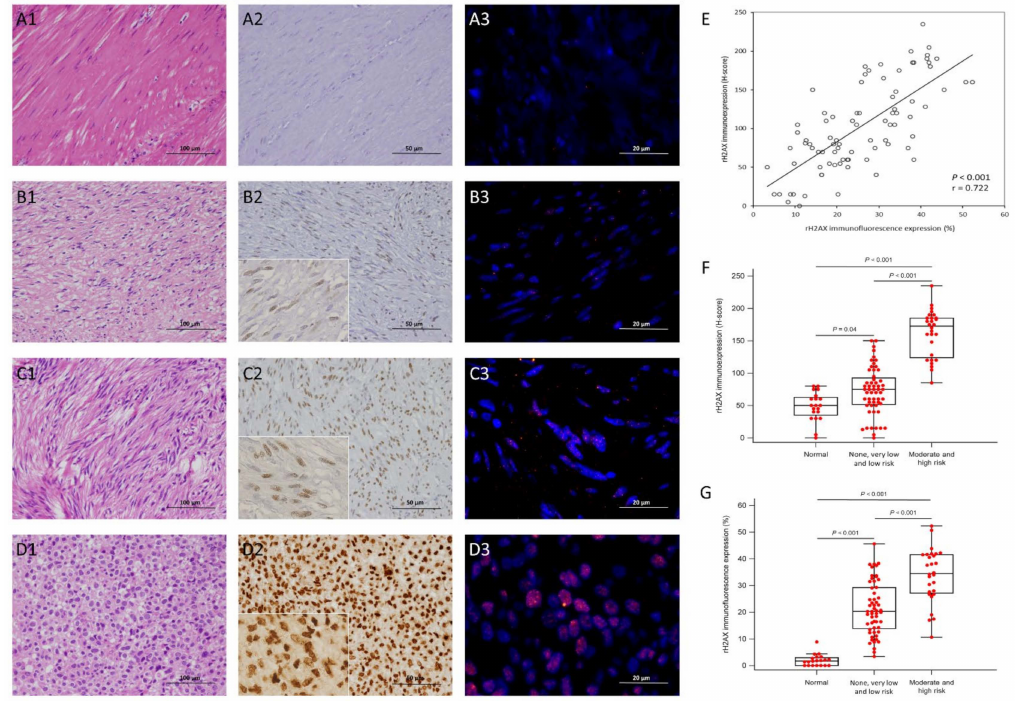
Figure 2. Immunohistochemical and immunofluorescence expressions of rH2AX in gastrointestinal stromal tumors across various risk categories. Representative adjacent normal tissue ( A1 ) and gastrointestinal stromal tumors (GISTs) at low-risk ( B1 ), moderate-risk ( C1 ), and high-risk ( D1 ) levels exhibited no ( A2 ) to weak ( B2 ), moderate ( C2 ), and diffuse strong ( D2 ) immunohistochemical (IHC) nuclear rH2AX reactivity ( × 200), respectively, in a granular pattern, as highlighted in the insets ( B2 – D2 , × 400). In the immunofluorescence analysis of rH2AX, the percentages of positively labeled nuclei, presenting as fine to coarse red speckles, increased gradually from normal ( A3 ) to low-risk ( B3 ), moderate-risk ( C3 ) and high-risk ( D3 ) GISTs. ( E ) The scatter plot reliably demonstrates a strong association between the H-score of rH2AX immunoexpression on the Y -axis and immunofluorescence expression on the X -axis ( p < 0.001, r = 0.722). Compared to the normal tissues, the expression levels of rH2AX determined by IHC (( F ) , p < 0.001) and IF (( G ), p < 0.001) assays were significantly elevated in the 84 GISTs; the major differences occurred in normal tissues versus none/very low-/low-risk cases (IHC, p = 0.04; IF, p < 0.001), and in the latter merged group versus the combined moderate/high-risk GISTs ( p < 0.001 for both IHC and